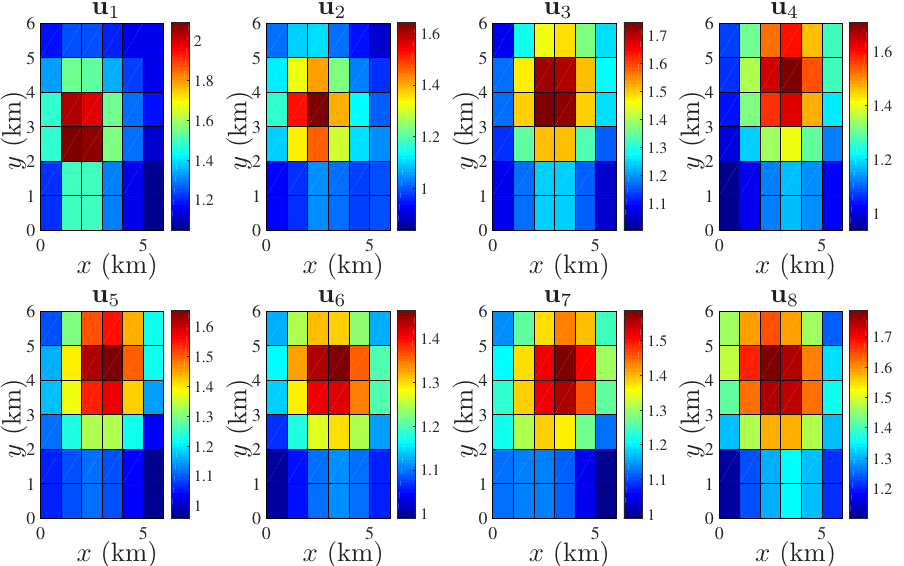
Figure 5. Spatio-temporal evolution of u t in a 6 × 6 square km area; spatial resolution: 1 × 1 square km; time varying H t for t = 1, . . . ,8; strength of spatial correlation: θ =